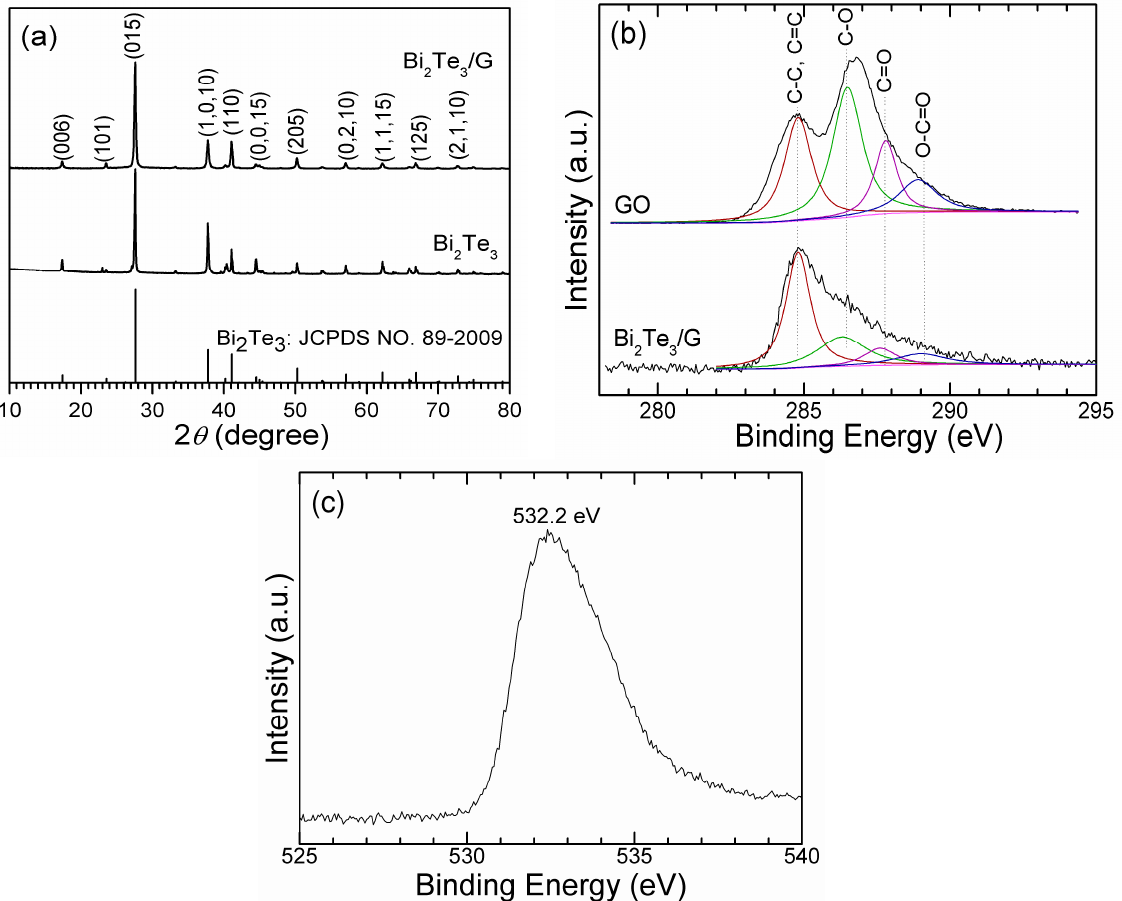
Te /G and bare Bi 2 3 Te 2 3